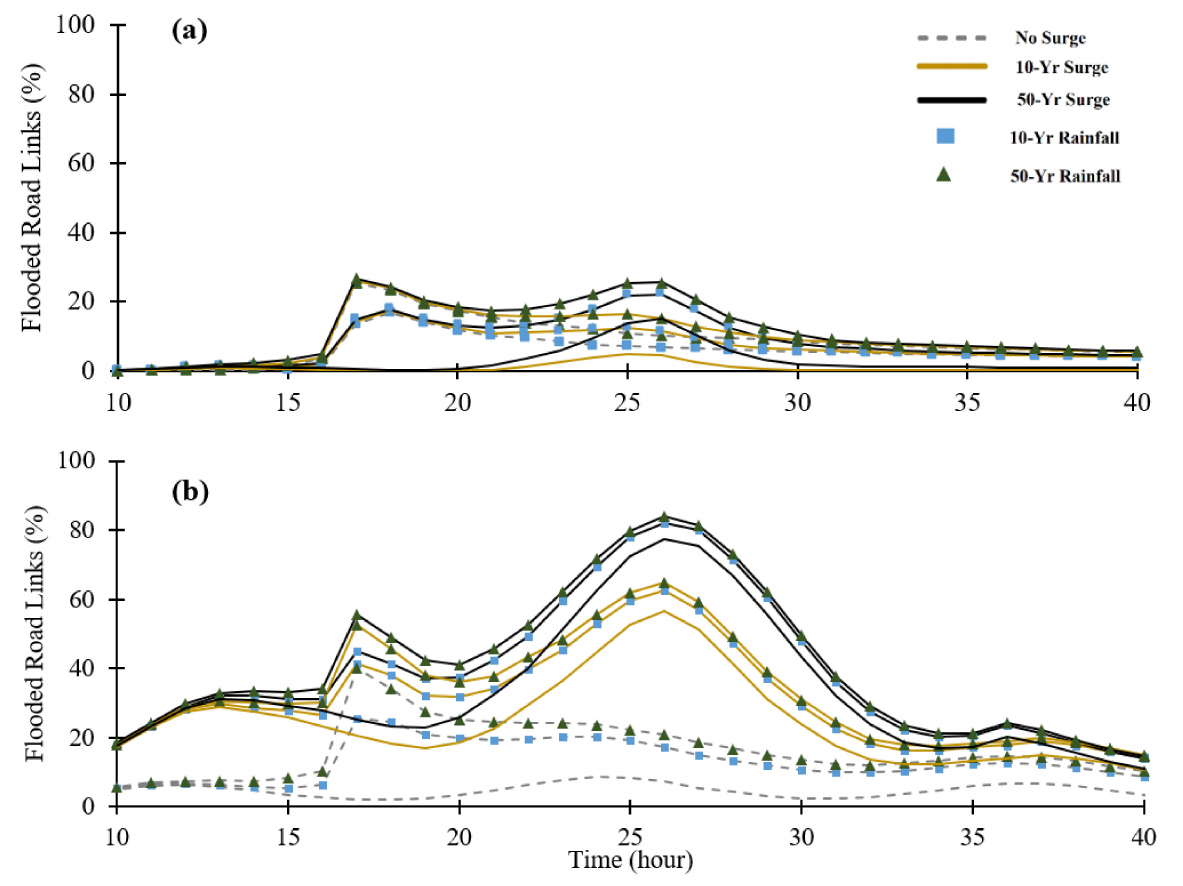
Figure 15. Percentage of flooded road links in time series during the simulation periods of all the tested combined storm scenarios: ( a ) current climate conditions and ( b ) 2070 high SLR scenario and RCP8.5 climate change scenario.